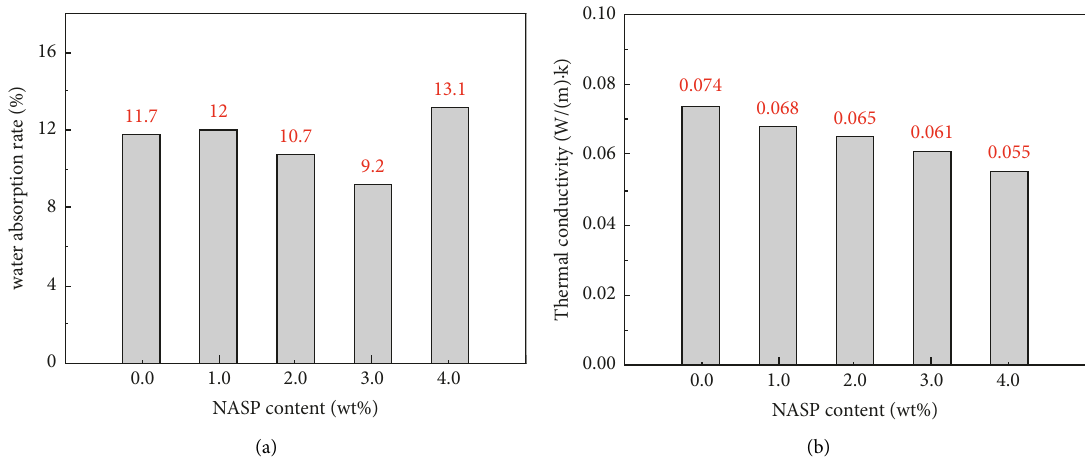
Figure 3: Effect of different NASP content on (a) water absorption rate and (b) thermal conductivity.